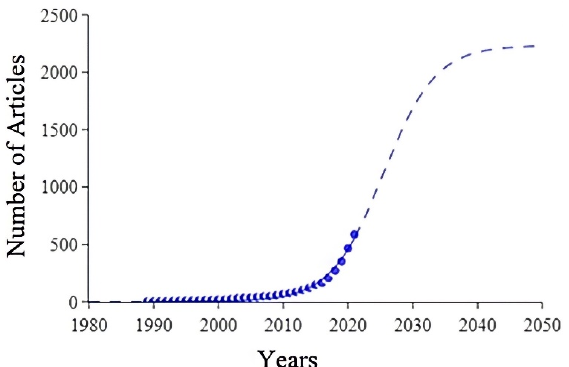
Figure 11. The growth trend of accumulated articles published over the